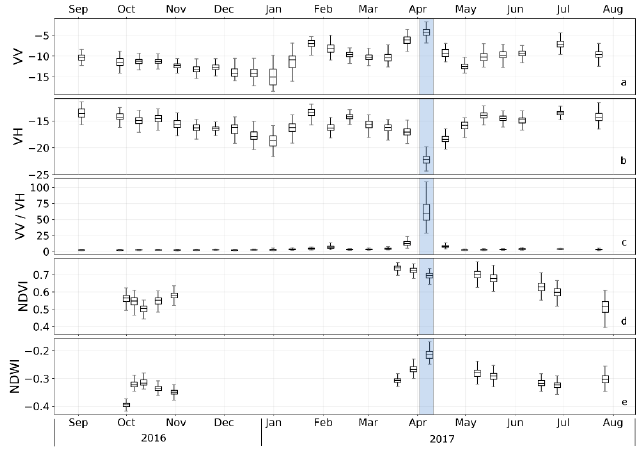
Figure 6. Multi-temporal behaviour of the backscatter intensity for TFV areas for VV ( a ), VH ( b ), the ratio VV/VH ( c ), NDVI values ( d ), and NDWI values ( e ). The blue bars mark the analysed date at the flood event.